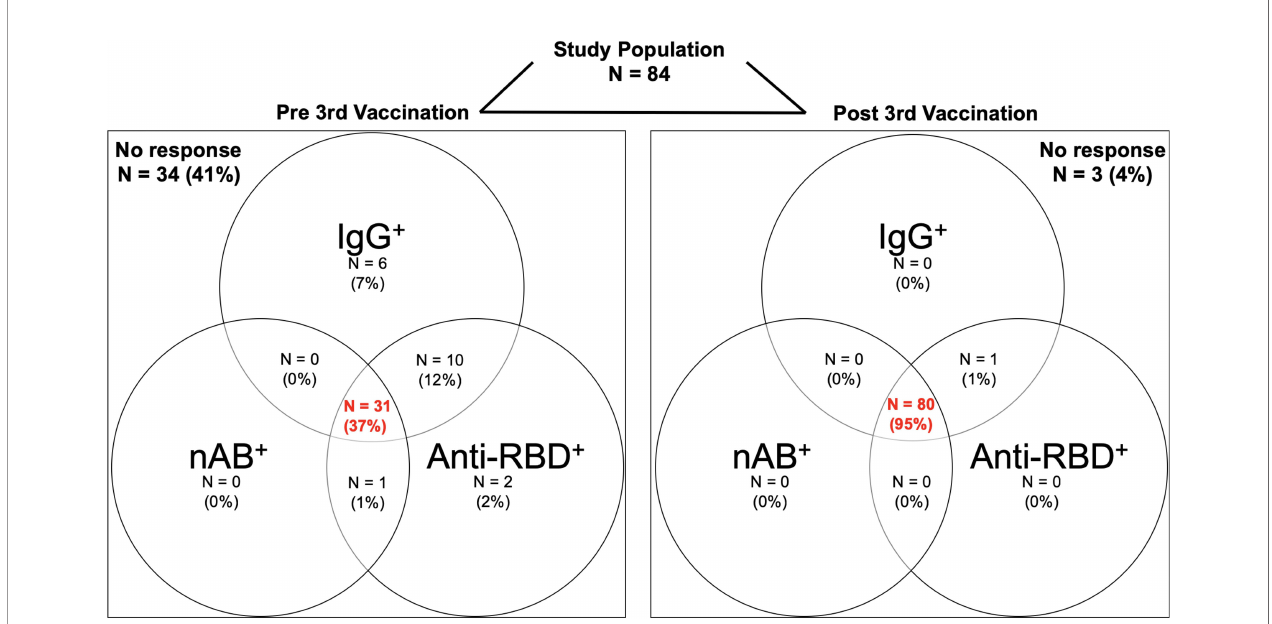
FIGURE 1 | Study population for assessment of humoral response before and after a third BNT162b2 vaccine dose in hemodialysis patients. Seropositivity for anti- S1 IgG, surrogate neutralizing and anti-receptor-binding domain (RBD) antibodies before and after a third BNT162b2 vaccine dose in 84 hemodialysis patients shown in a Venn-Diagram. Seropositivity was de fi ned as an anti-S1 IgG index ≥ 1 in a chemiluminescent immunoassay, an inhibition ≥ 30% in a surrogate virus neutralization test, and a mean fl uorescence intensity (MFI) ≥ 5800 in a bead-based multiplex assay. The red, bolt numbers in the middle of each panel indicate the proportion of patients with seropositivity for all three assays. N, number; nAB, neutralizing antibodies; RBD, receptor-binding